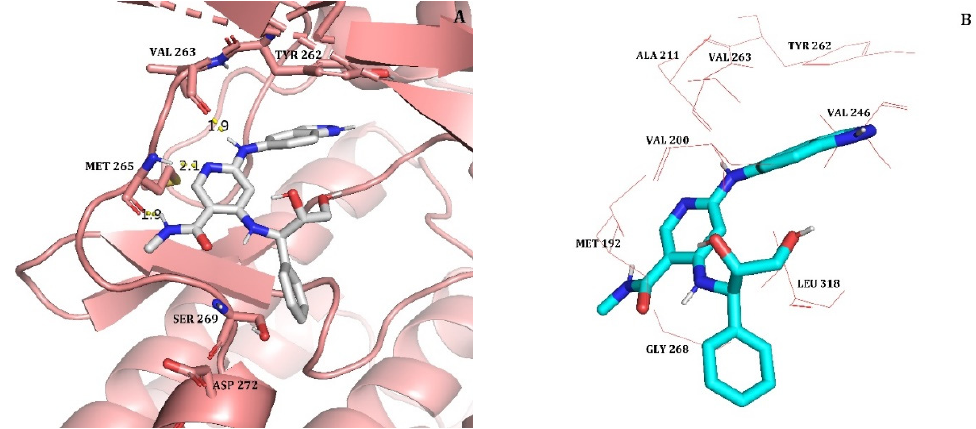
Figure 3. ( A ) 50 ns MD conformation of the most active compound 33 (shown in white color and stick model) inside the active site of IRAK4. Hydrogen bonds are represented as yellow dotted lines and their distances are labeled in angstrom. ( B ) The most active compound 33 (shown in cyan, stick model) inside the hydrophobic pocket of IRAK4; surrounded by hydrophobic residues (red colored line representation).